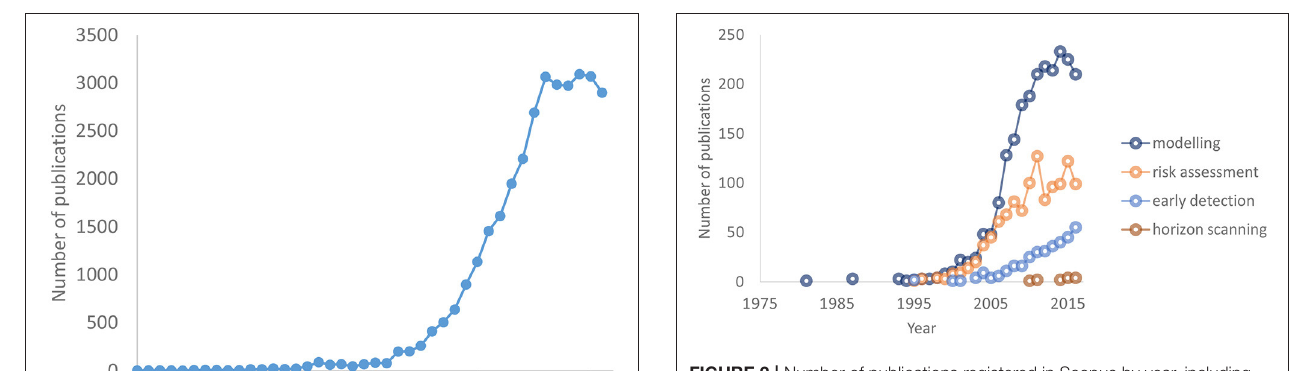
FIGURE 2 | Number of publications registered in Scopus by year, including the words “biological invasions” or “non-indigenous species” or “alien species” or “invasive species” and one of the following words: “modeling,” “risk assessment,” “early detection,” and “horizon